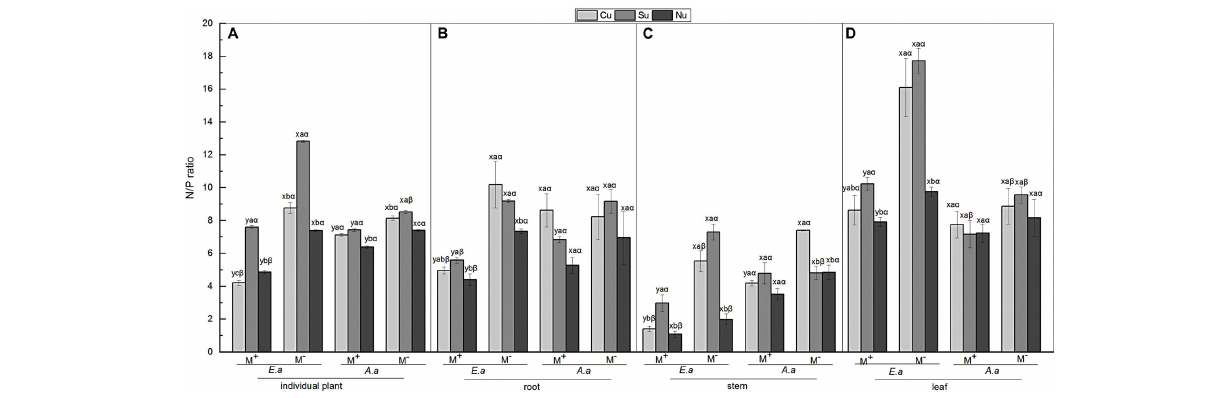
for individual plant N/P ratio, under M − treatment, the N/P ratio of invasive E. adenophorum was significantly higher than